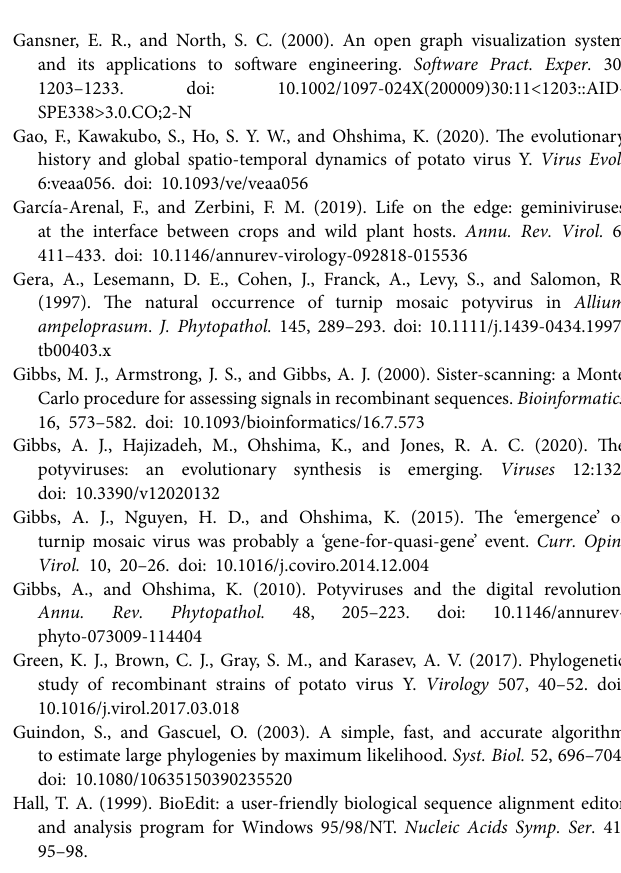
Supplementary Figure S1 | Workflow for full genomic sequencing of scallion mosaic virus. Black lines with arrow heads show the amplified regions by RT-PCR for cloning or direct sequencing for all isolates, and blue lines with arrow heads show the amplified regions to confirm the sequences by direct sequencing for some isolates. Numbers in parenthesis correspond to the genomic positions of Chinese isolate (Chen et al., 2002). NCR; non-coding region, P1; first protein, HC-Pro; helper- component proteinase protein, P3; third protein, 6 K1; first 6 kDa protein, CI; cylindrical inclusion protein, 6 K2; second 6 kDa protein, VPg; genome-linked viral protein, NIa-Pro; nuclear inclusion a proteinase protein, NIb; nuclear inclusion b protein, and CP; coat protein. The nucleotide sequences of the genomes of 16 out of 63 isolates were obtained from the cloned plasmids (see Supplementary Table S2 ). Supplementary Figure S2 | SIMPLOT and GARD analyses of the full genome sequences of scallion mosaic virus. (A) Similarity plot with non-recombinants and recombination-type pattern 1 genome sequences were used as the query isolates. Graph of the similarities between the genome sequences of non-recombinants (WOA294, China, and WOEH272) or recombination-type pattern 1 (WOC441) and those of other isolates which belong to other recombination-type patterns. Arrows indicate the position where recombination occurred. The similarities were estimated using SIMPLOT version 3.5.1. Sliding window of 200 nucleotides and step size of 20 nucleotides. (B) The best placement of recombination sites (breakpoints) inferred by the algorithm for each number of site considered by